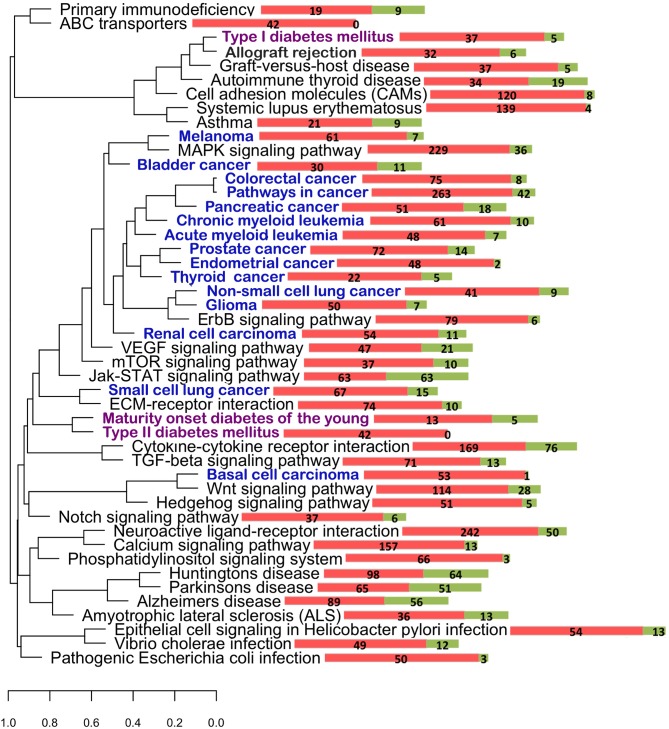
Hierarchical clustering of human disease and environmental information processing pathways in respect to the SRV+ genes that are shared between the pathways.The bars next to the pathways denote the number of SRV+ genes (red) and SRV- genes (green) in the corresponding pathways. Cancer related pathways are marked in blue; metabolic disease pathways are in purple. Note that ABC transporters and Type II diabetes mellitus pathways are exclusively composed of SRV+ genes.